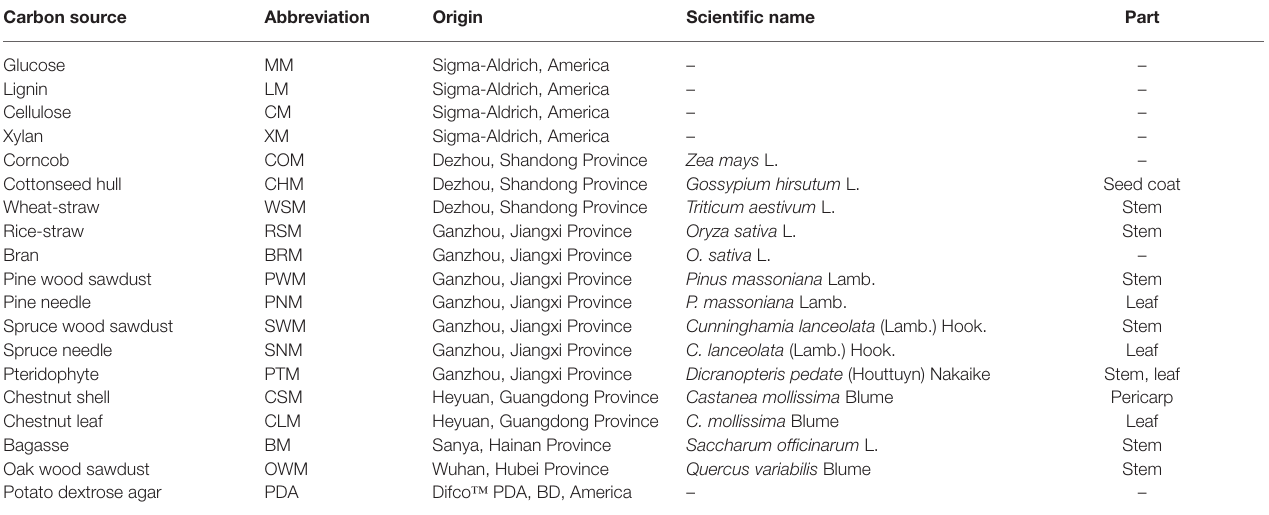
TABLE 1 | Carbon sources used in this